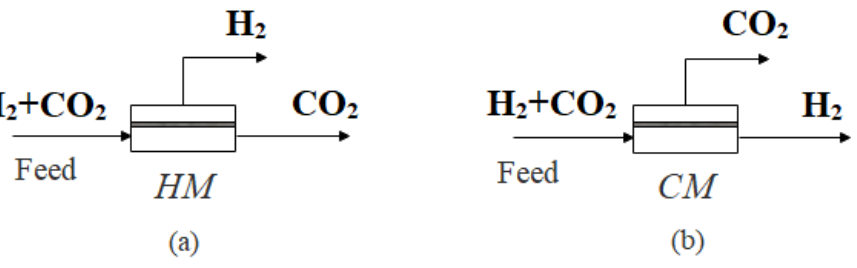
Figure 3. Schematic diagram of single-stage membrane separation. ( a ) H 2 -selective membrane; ( b ) CO 2 -selective membrane.